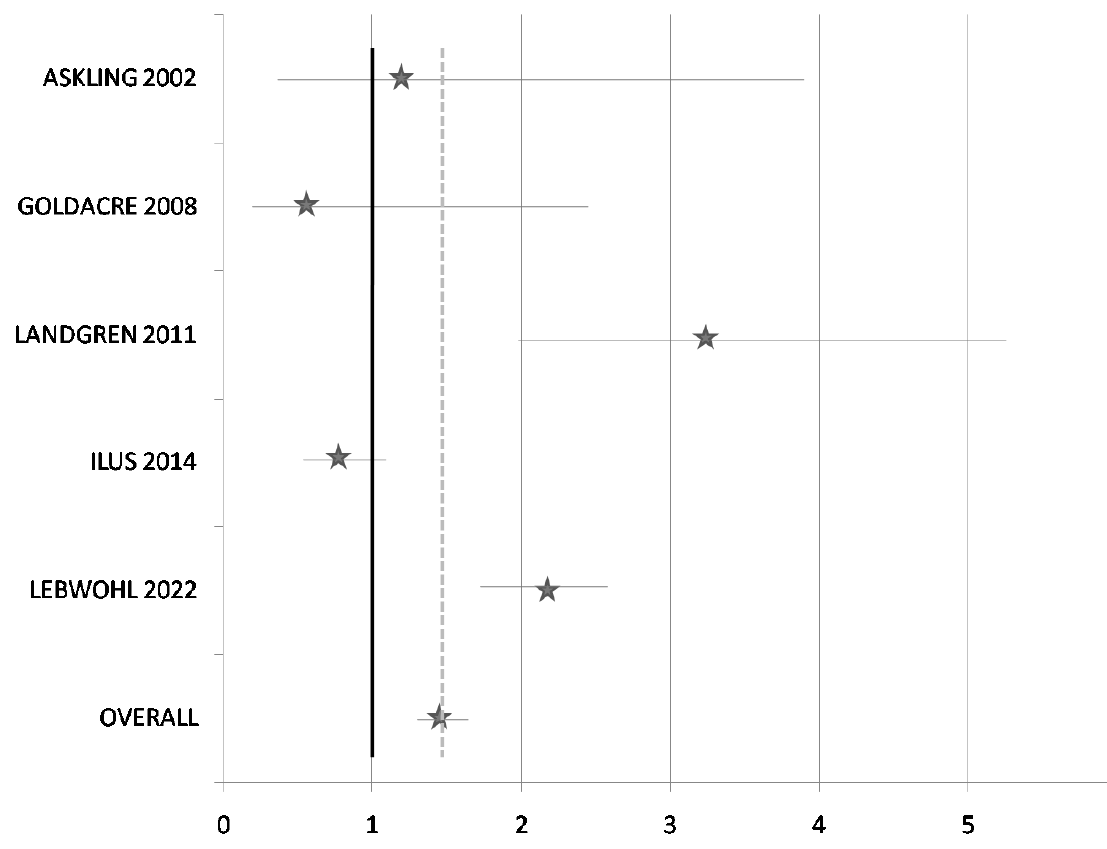
Figure 2. Forest plot for the association between celiac disease and pancreatic cancer [30,32,34–36].